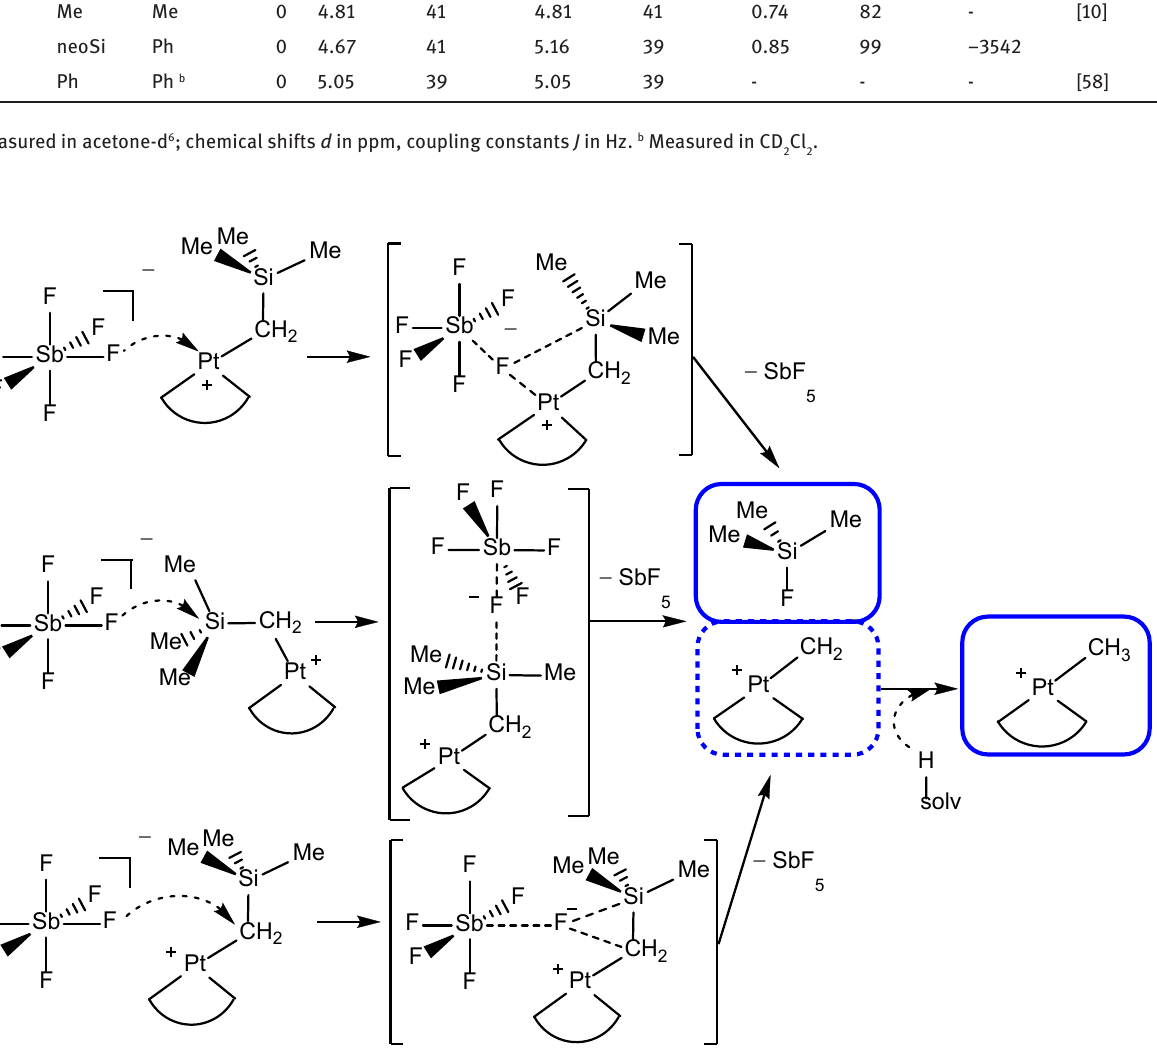
Scheme 2: Possible [Pt(cod)(neoSi)] +… SbF 6– adducts and pathways for the decomposition of the neoSi ligand in [Pt(cod)(neoSi)] + complexes through [SbF ] – . Experimentally observed species marked in 6